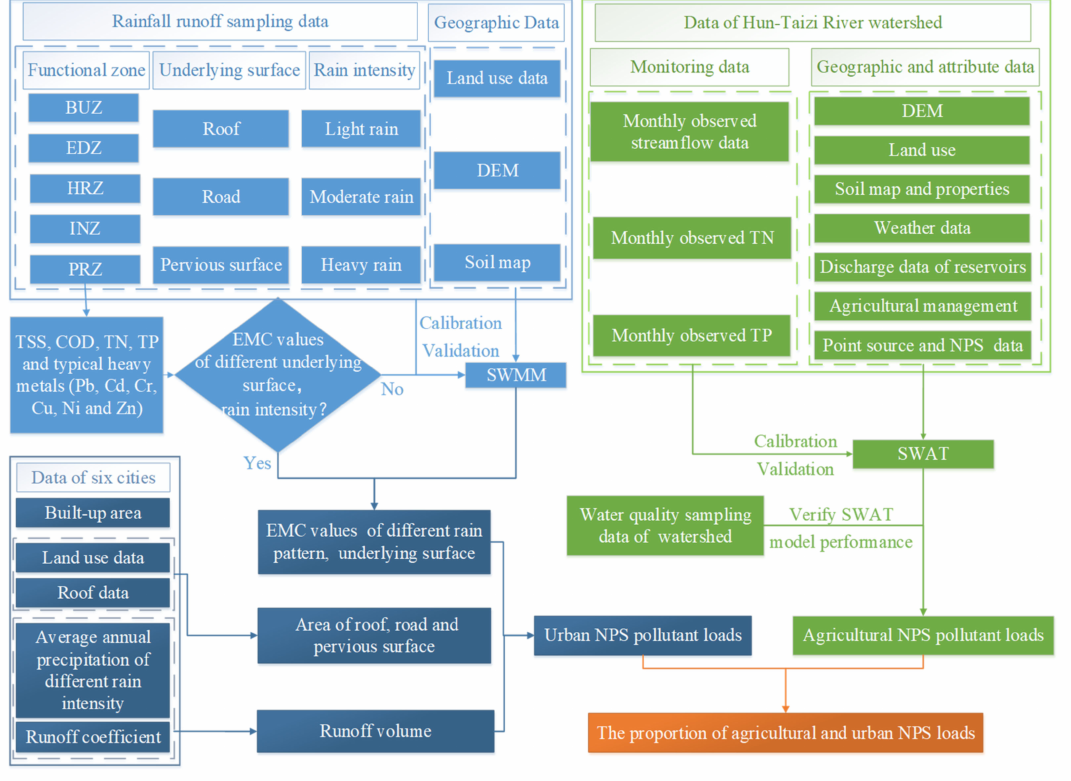
Figure 5. Schematic framework of the study. Business zone (BUZ), high density residential zone (HRZ), educational zone (EDZ), industrial zone (INZ), preservation zone (PRZ), digital elevation model (DEM), total suspended solids (TSS), chemical oxygen demand (COD), total nitrogen (TN), total phosphorus (TP), event mean concentration (EMC), Storm Water Management Model (SWMM), Soil and Water Assessment Tool (SWAT), and non-point source